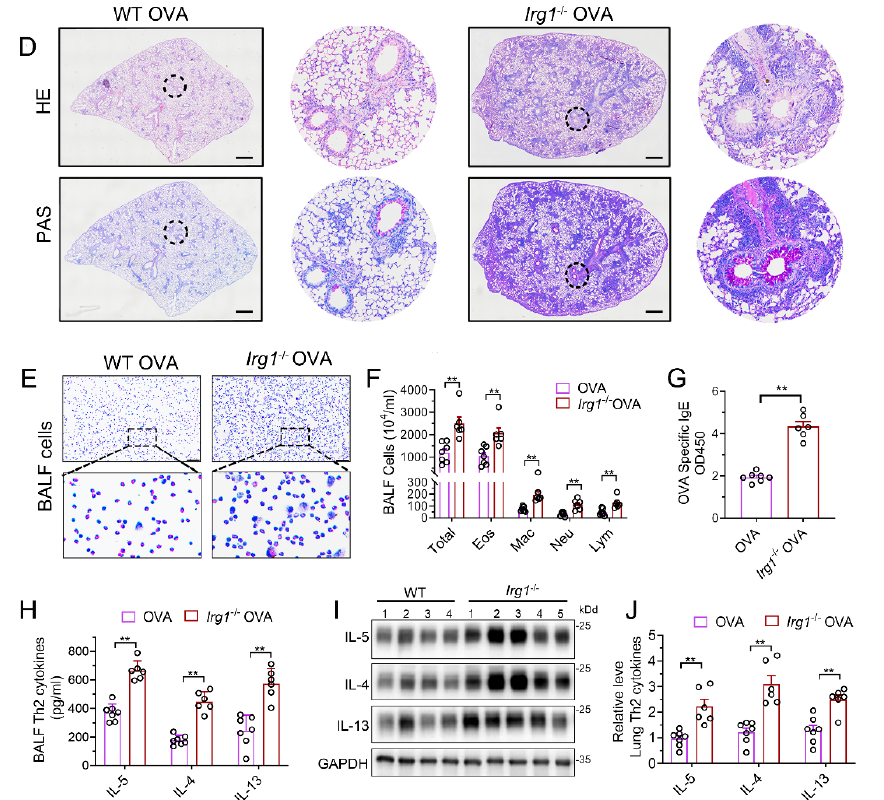
Figure 3. Allergic airway inflammation is augmented in OVA − challenged Irg1 − / − mice. ( A ) Representative histogram showing the purity of isolated AMs gated on CD45 + F4/80 + CD11b − CD11c + . ( B ) Representative images of isolated AMs stained with Wright–Giemsa solution. Scale bar: 25 µ m. ( C ) Western blot showing Irg1 protein induction in isolated AMs from WT and Irg1 − / − mice and stimulated with OVA (500 ng/mL) for 24 h. ( D ) Representative whole lung sections stained with HE and PAS; scale bar: 500 µ m. ( E ) Representative images of BALF cells stained with Wright–Giemsa solution. Scale bar: 50 µ m. ( F ) The number of total inflammatory cells, eosinophils, macrophages, neutrophils and lymphocytes in BALF. ( G ) The optical density value (OD value) measured at 450 nm represents the level of IgE in serum. ( H ) The level of Th2 cytokines IL-5, IL-4 and IL-13 in BALF. ( I ) Representative blots showing the protein expressions of Th2 cytokines IL-5, IL-4 and IL-13 in lung tissues from WT and Irg1 − / − mice challenged with OVA. ( J ) Quantification of the expression of IL-5, IL-4 and IL-13 in the lung as referencing to GAPDH. Cropped blots are shown, and Supplementary File S2: Figures S4 and S5 present the full-length blots. Data expressed as means ± SEM ( n ≥ 6). ** p <